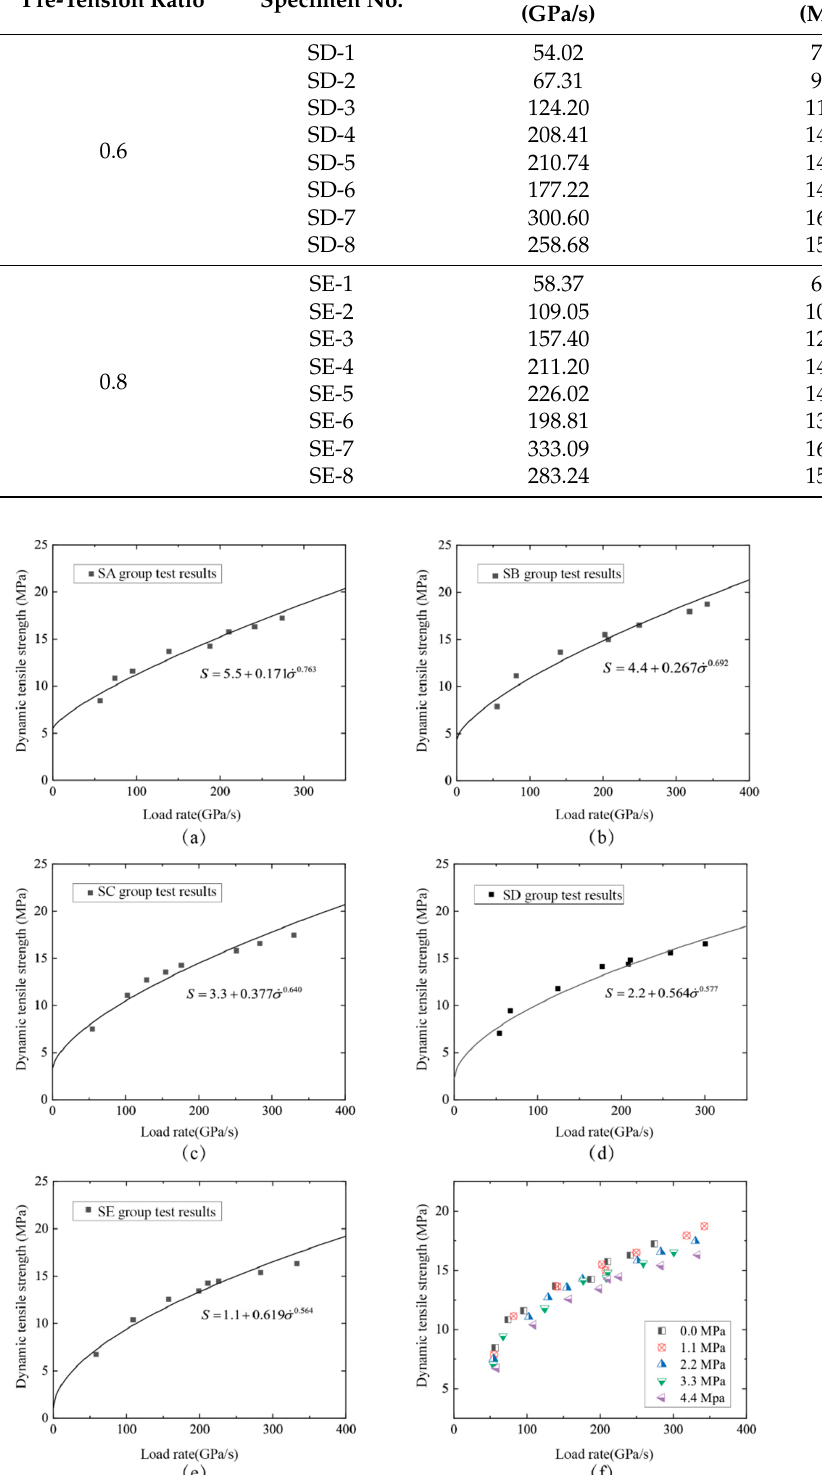
Figure 6. The variation of dynamic tensile strength versus loading rate at a specified static pre- tension: ( a ) 0 MPa for group SA; ( b ) 1.1 MPa for group SB; ( c ) 2.2 MPa for group SC; ( d ) 3.3 MPa for group SD; and ( e ) 4.4 MPa for group SE. Panel ( f ) shows the relationship between dynamic tensile strength and loading rate at certain pre-tension ratios.